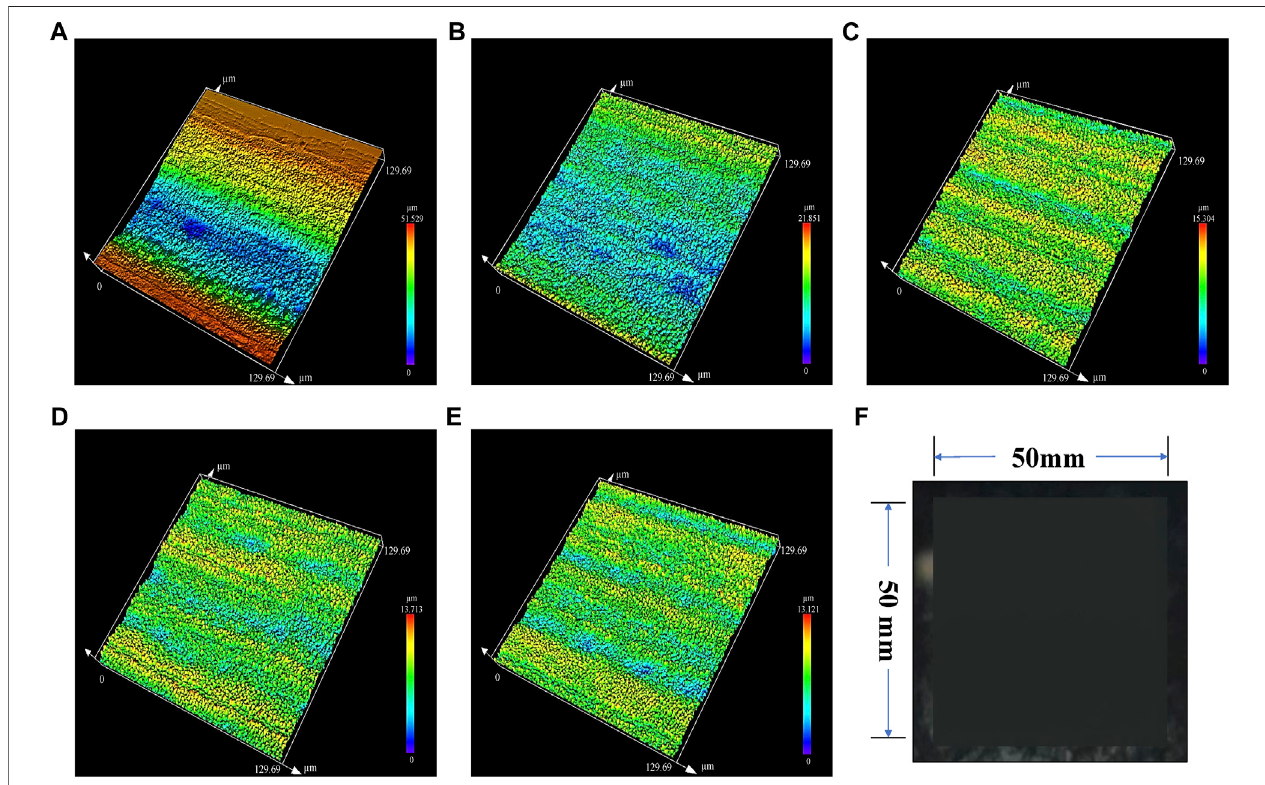
FIGURE6| 3Dimagesofsampleswithdifferentpitchesbetweenrows,including (A) 5 μ m, (B) 15 μ m, (C) 25 μ m, (D) 35 μ m,and (E) 45 µm. (F) Imageof50-mm× 50-mm black silicon.